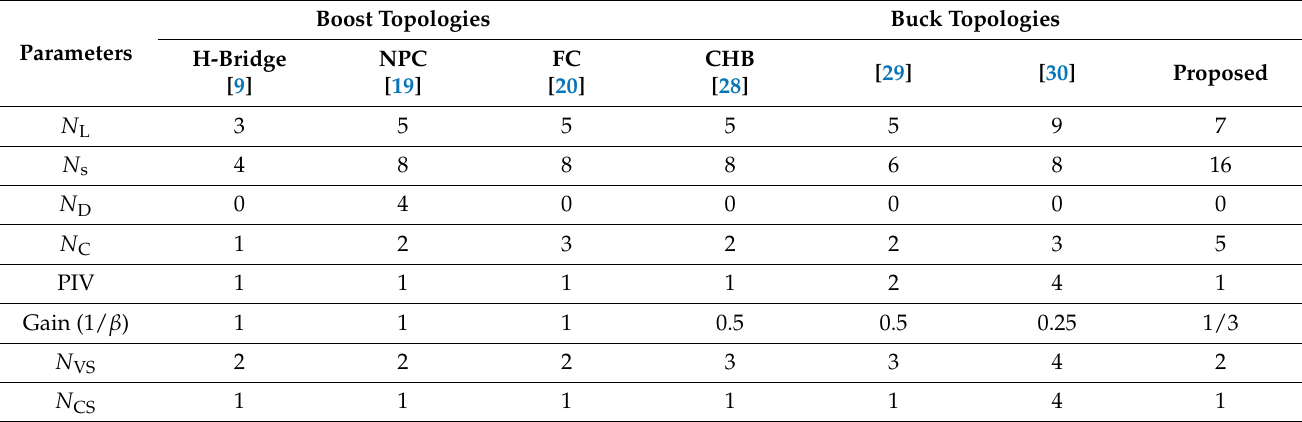
Table 3. Comparison of proposed work with single phase buck and boost rectifier topology. Boost Topologies Buck Parameters